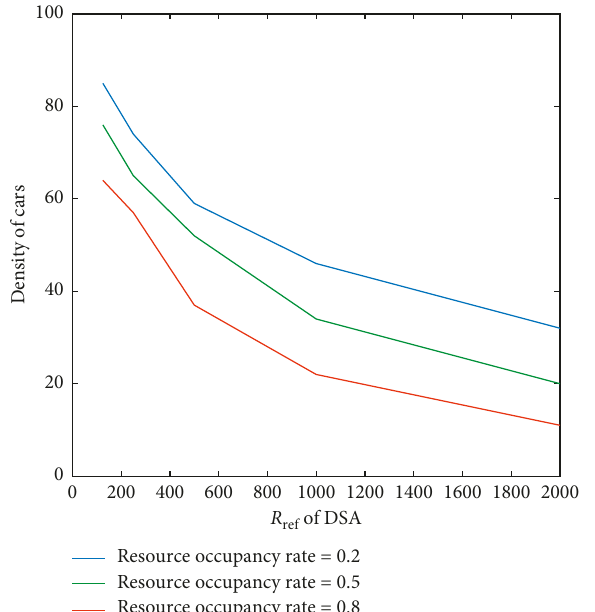
Figure 6: Nash equilibrium of the game between FNs.